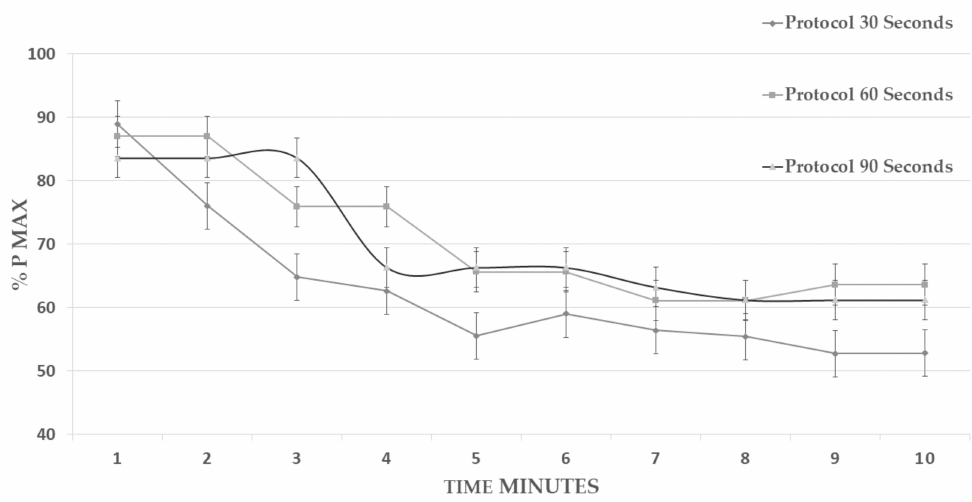
Figure 5. Development of maximum power of the different HIIT